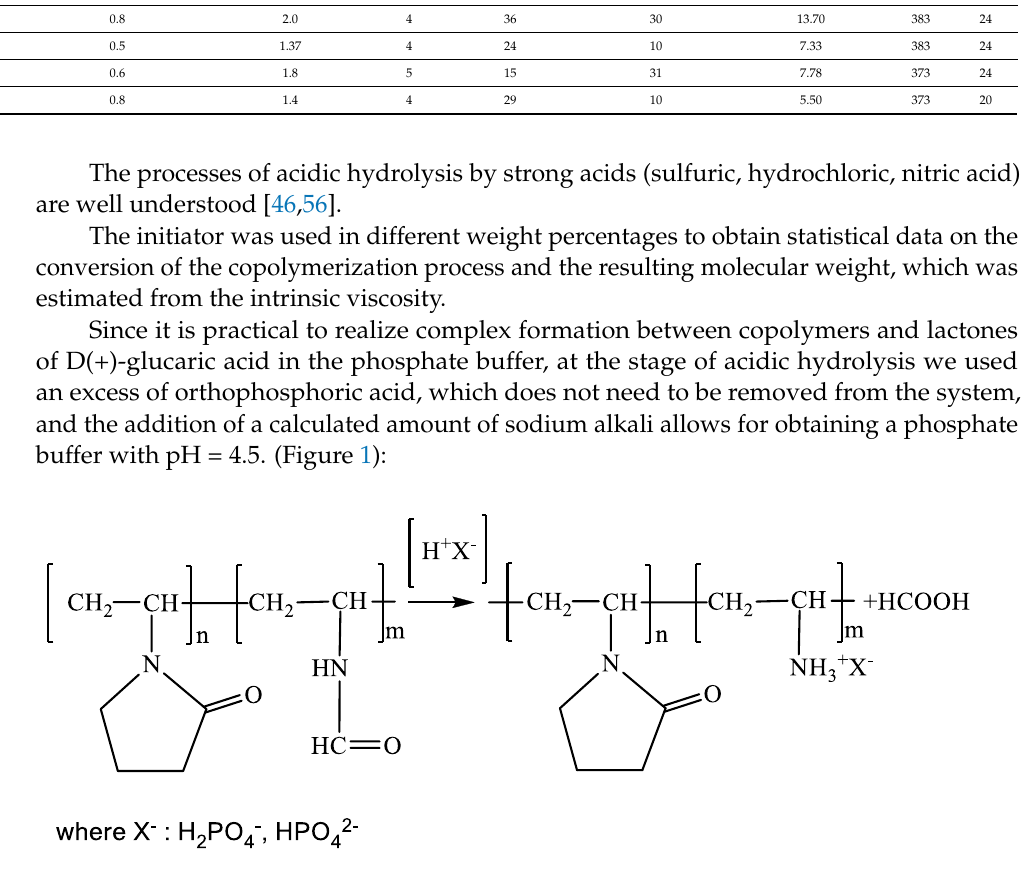
Figure 1. Scheme of acidic hydrolysis of copolymer [N-VP] n -[N-VFA] m by phosphoric acid. Acidic hydrolysis and the appearance of [N-VP] n -[N-VA] m X − were monitored by TLC (detection of the released formic acid). The proposed technique offered the possibility of reliable control of the chromatographic zone of formic acid (retention factor R f = 0.9), since the copolymer [N-VP] n -[N-VA] m becomes adsorbed at the start ( R f = 0). Molecular mass distributions (MMD), polydispersity, compositional homogeneity, the absence of monomers, and other low molecular weight compounds are important for polymers intended for biomedical applications. The presence of residual monomers in the products of N-VP/N-VA copolymerization was detected by TLC. The TLC chro- matographic system was selected on the basis of the theory of eluotropic series (Snyder’s solvent selectivity triangle) [57] and solvent strength (S i ) for direct-phase TLC (“Prizma” model) [58]. The ternary eluent (chloroform (S i = 4.1), ethyl acetate (S i = 4.4), and aque- ous solution of ammonia (S i = 10.2)) was selected in such a way that the mobility of the [N-VP] n –[N-VFA] m copolymer under these conditions was equal to zero. Thus, it was possible to reliably register the presence of residual monomers N-VP (R f = 0.84) and N-VFA (R f = 0.58) in the reaction